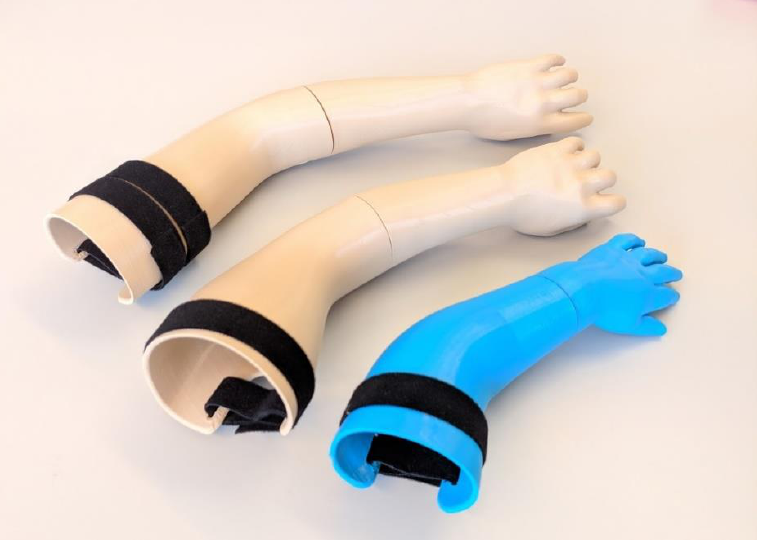
Figure 22. Prostheses made for pediatric patients and put to use on the basis of the study results.